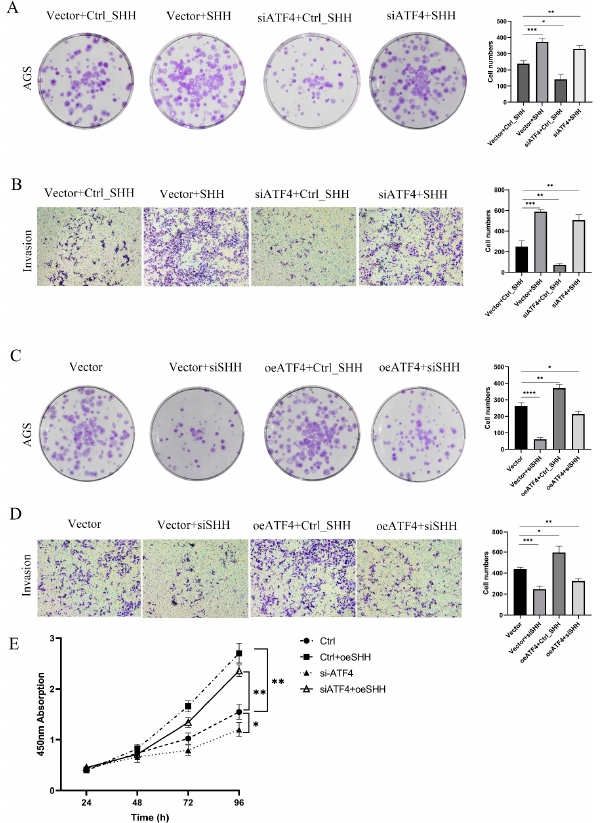
Figure 5. ATF4 regulates the proliferation and invasive ability of gastric cancer cells through SHH. ( A ) After SHH overexpression, the proliferative capacity of AGS knockdown ATF4 cells was nearly restored to its initial level as compared to the group transfected with si-ATF4 lentivirus and pcDNA